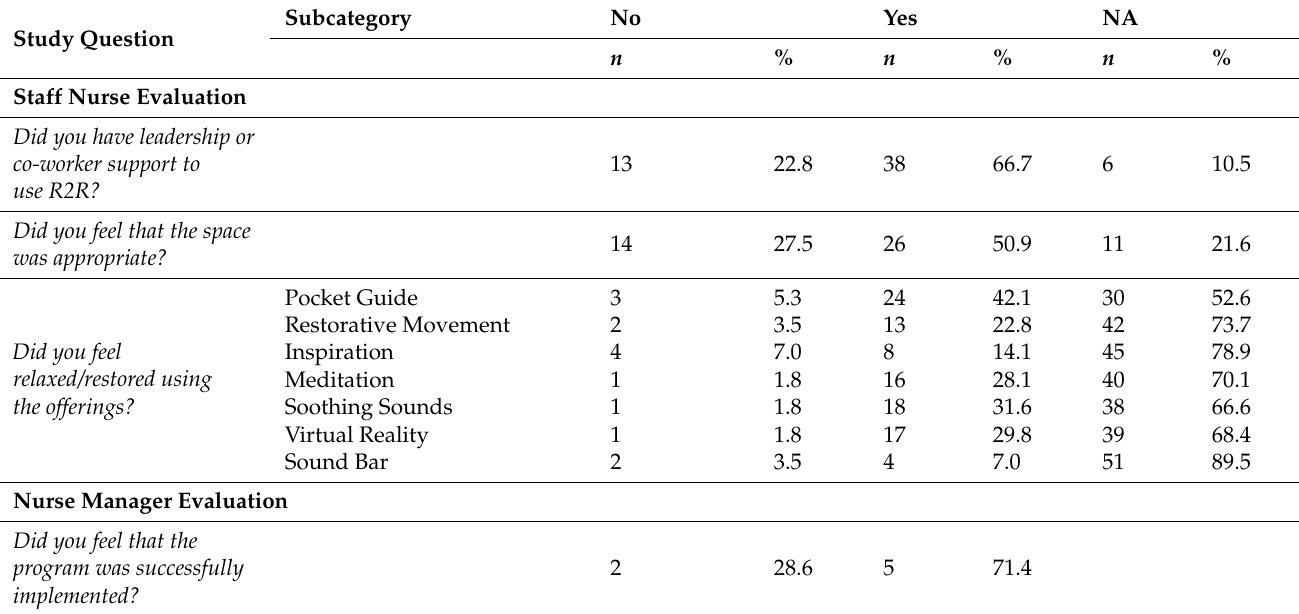
Table 8. Perceptions of Program Success, Support, Restoration,